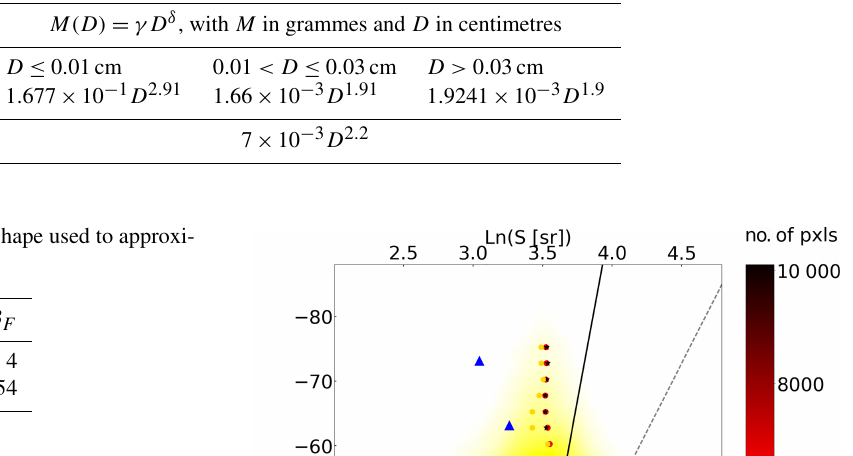
Table 3. Mass–diameter relationships used in Varcloud.